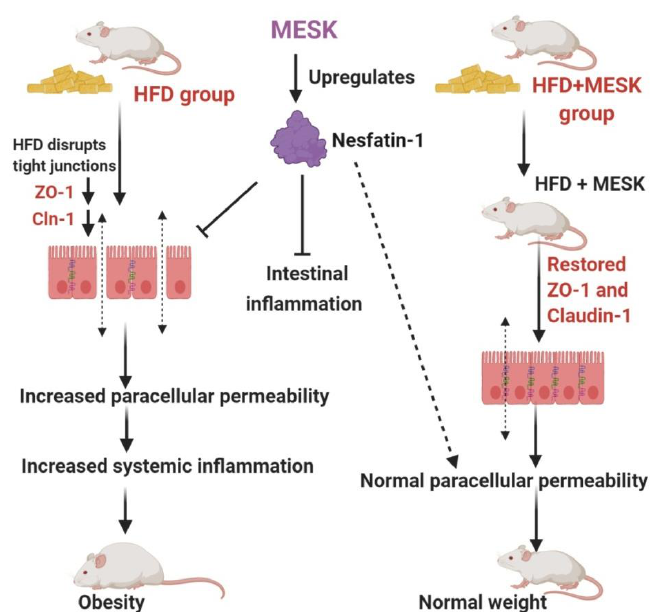
Figure 18. Flow chart explaining the anti-obesity and gut barrier-protective effects of MESK. MESK upregulated the expression of Nesfatin-1, which in turn reduced food intake and also the disruption of the gut barrier and prevented obesity and associated metabolic complications.